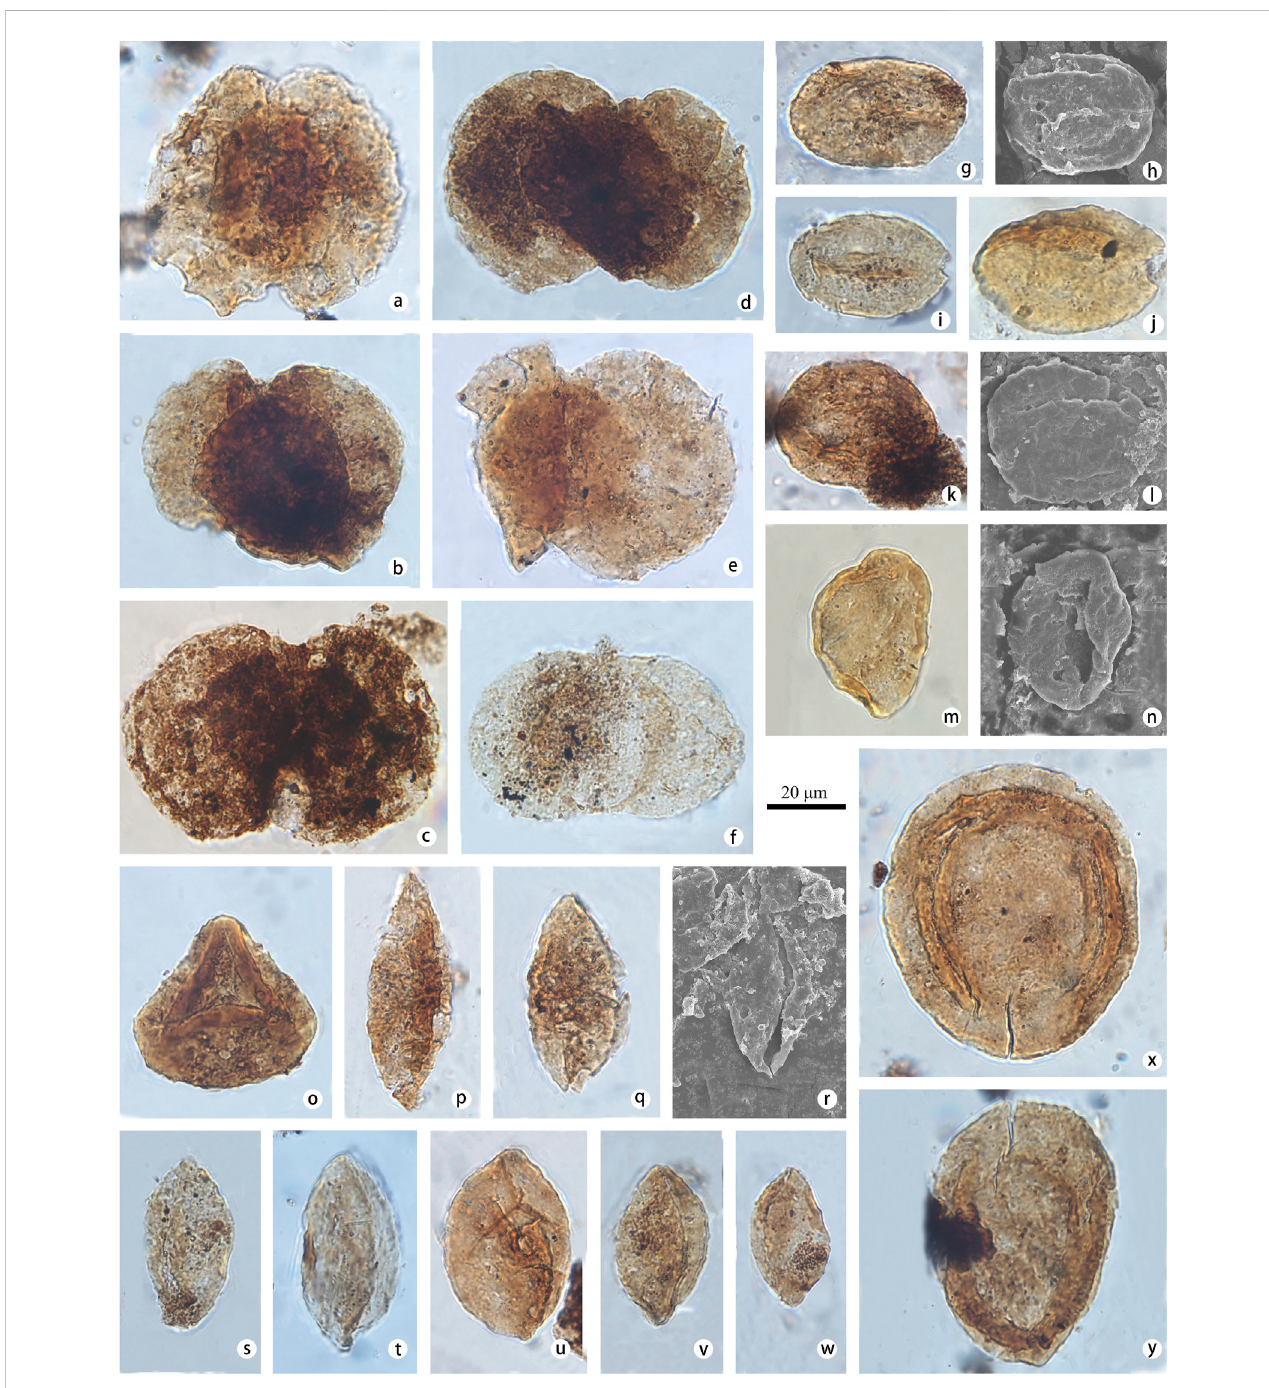
FIGURE 4 Selectedpollenidenti fi edattheYunmengpro fi le(taxonnameisfollowedbysamplenumberandpositioninEngland fi nderorstubnumberinparentheses). (A) Podocarpidites paulus (Bolkh.) (Xu and Zhang, 1980) (a-STYM16, P7-2); (B, C) Podocarpidites ornatus (Pocock, 1962) (b-STYM94, M34-4; c-STYM97, M34-1); (D,E) Podocarpiditesunicus (Bolkh.)(Pocock,1970)(d-STYM-88,N35-2;e-STYM16,R42-1); (F) Podocarpiditesmulticinus (Bolkh.)(Pocock,1970)(f-STYM30,I29- 4); (G – J) Ovalipollisovalis (Krutzsch,1955)(g, h-STYM01,O23-1,Stub-01; i-STYM26, P36-1; j-STYM01, N33-1); (K,L) Ovalipollisbreviformis (Krutzsch, 1955) (k,l-STYM21,Q37-3,Stub-21); (M,N) Chasmatosporitesapertus (Rogalska)(Nilsson,1958)(m,n-STYM12,T20-3,Stub-12); (O) Duplicisporitesgranulatus (Leschik, 1955) (o-STYM94, L37-4); (P – R) Cycadopites typicus (Maljavkina) (Pocock, 1970) (p-STYM48, D46-1; q, r-STYM16, T23-2, Stub-16); (S) Cycadopites adjectus (De Jersey,1964)(s-STYM27,I34-2); (T) Cycadopitestivoliensis (DeJersey,1971)(t-STYM28,M47-4); (U – W) Ginkgocycadophytus